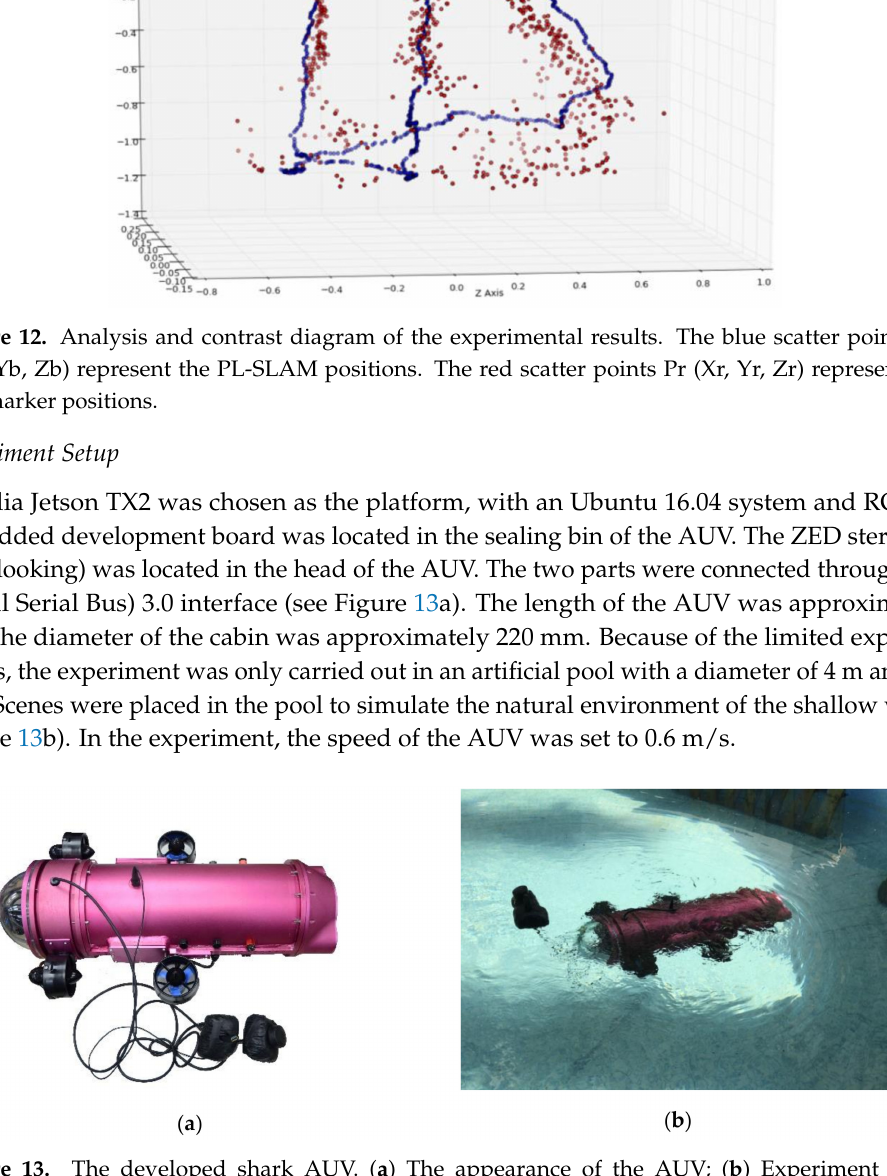
Figure 13. The developed shark AUV. ( a ) The appearance of the AUV; ( b ) Experiment in an artificial